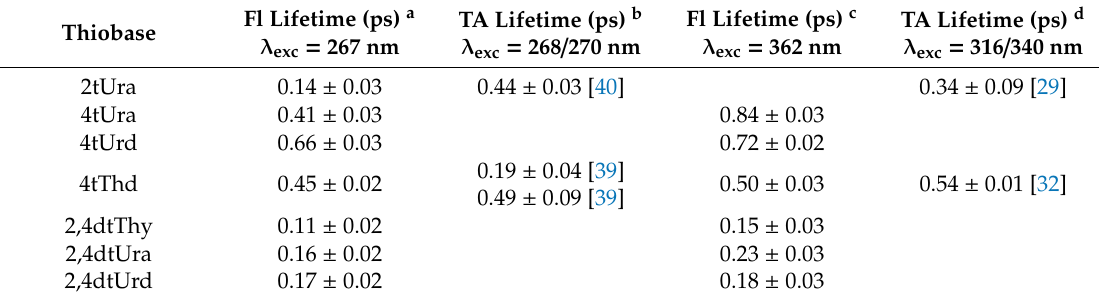
Table 2. Fluorescence (Fl) and transient absorption (TA) lifetimes of the thiopyrimidine derivatives in acetonitrile. Uncertainties for the fluorescence lifetimes correspond to one standard